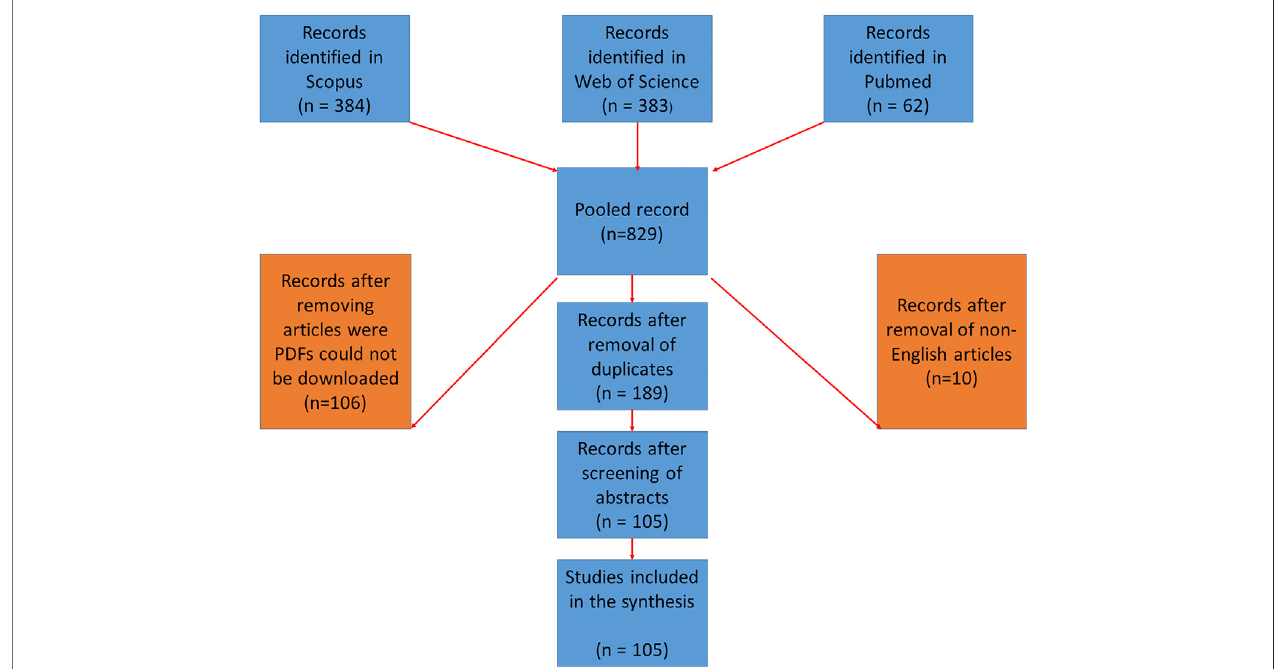
FIGURE 1 | PRISMA diagram of the selected articles for the literature